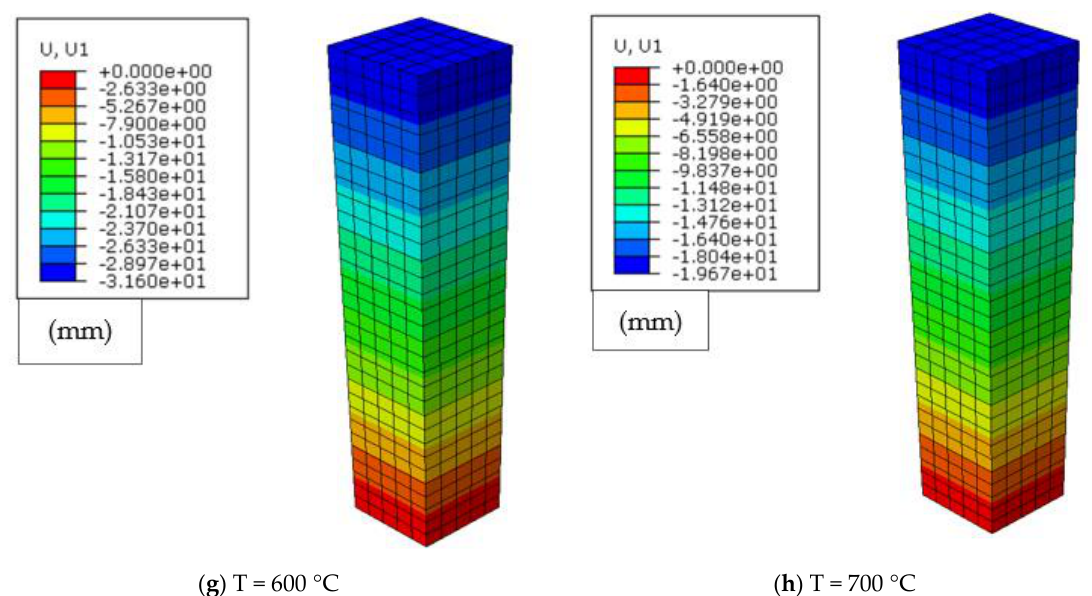
Figure 8. Vertical displacement nephograms of axially compressive concrete column at different temperatures.